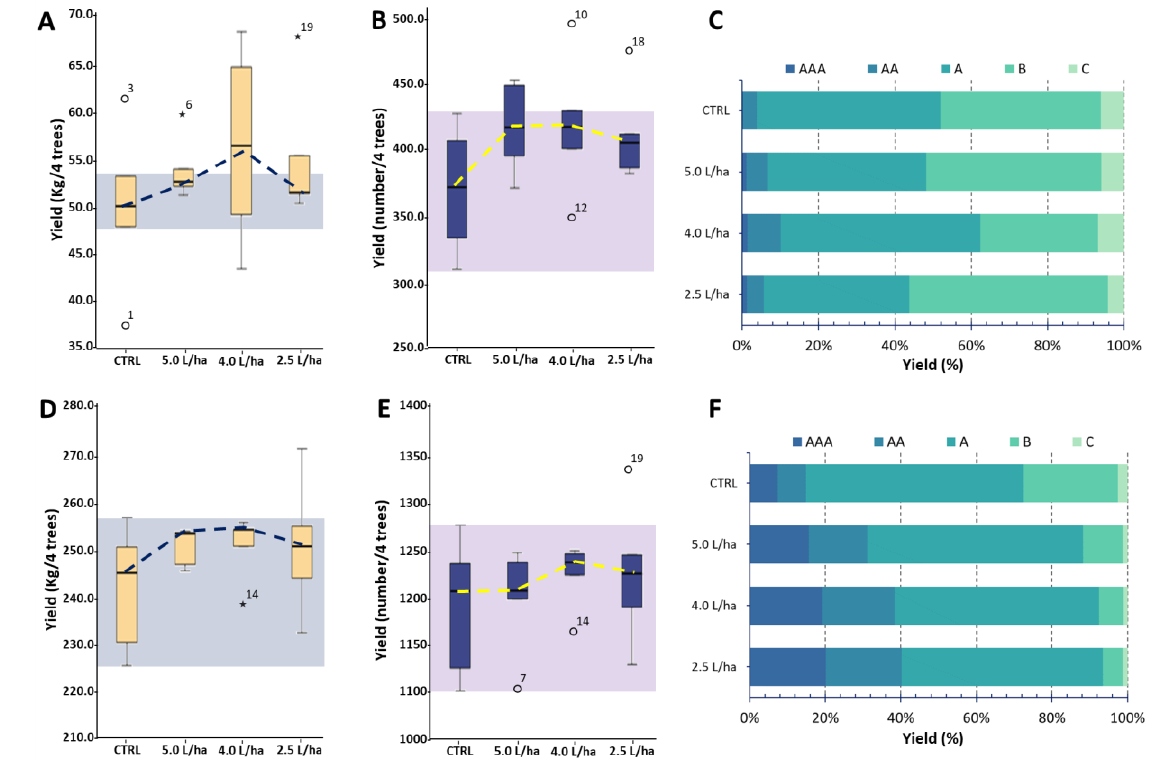
Figure 1. Agronomic yield data recorded for “Sugar Time” ( A – C ) and “West Rose” ( D – F ) varieties after treatment with different biostimulant dosages (5.0, 4.0 or 2.5 L/ha) or with water only. In the different panels, CTRL identifies samples harvested from trees treated with water only. ( A , D ) The production weight per four trees; ( B , E ) the number of produced fruits per four trees. Within each box, the horizontal, black lines indicate median values, while the boxes extend from the 25th to the 75th percentile of the distribution of the values in each group. Moreover, the extended vertical lines indicate standard deviations. The dotted lines represent the treatment trend, plotted considering the median value for each sample. Finally, the colored background reports the control values within which a significance of the data cannot be recorded. ( C , F ) The distribution of the fruit size (AAA, AA, A, B or C) in relation to the total production yield.